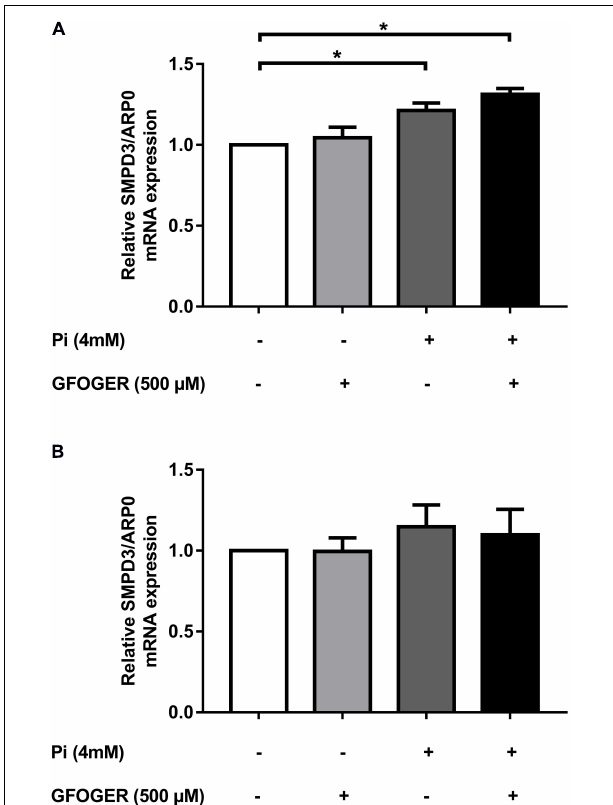
FIGURE 3 | Effects of GFOGER on EVs’ biogenesis. MOVAS-1 cells were incubated with 500 µ M GFOGER peptide in the presence or absence of 4 mM Pi for 24 h (A) and 8 days (B) . Gene expression of EVs’ biogenesis marker (SMPD3) was then quantified by RT-qPCR and normalized to the housekeeping gene ARP0. Data are expressed as mean ± SEM of four independent experiments done in triplicate ( n = 4). * p < 0.05 vs. 4 mM Pi; Mann–Whitney